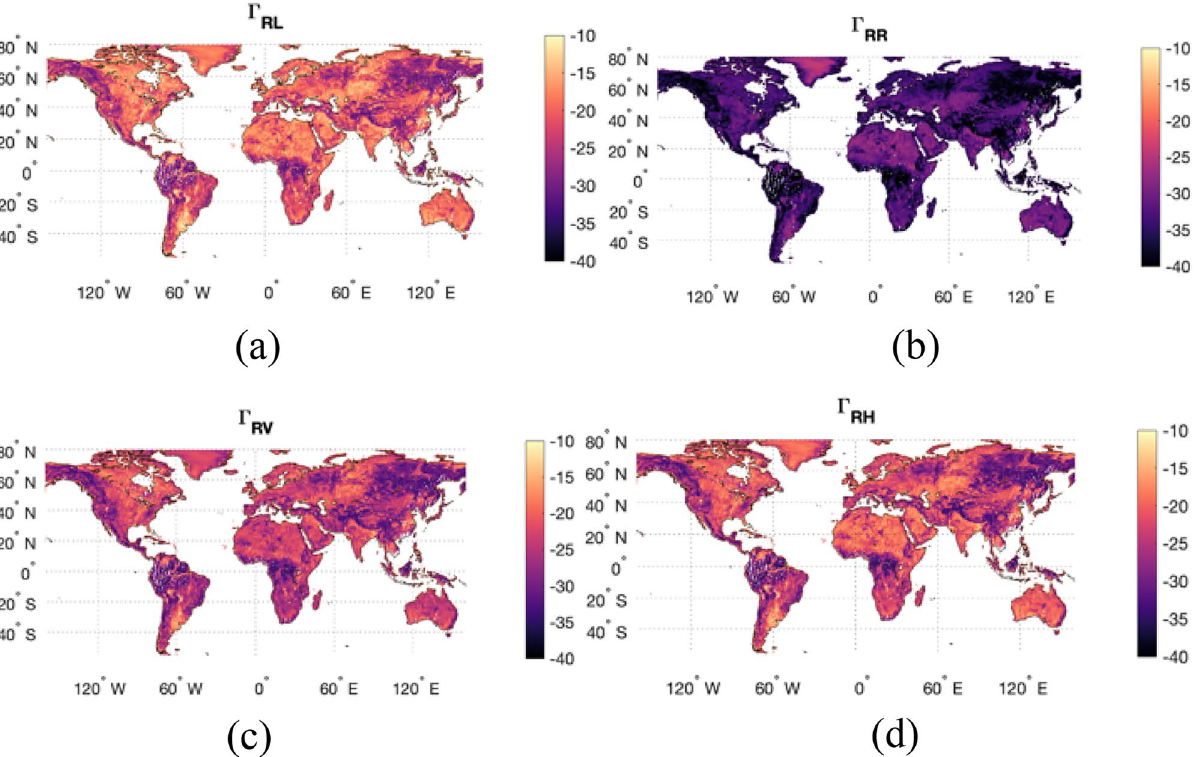
Figure 1. Contrast between bistatic radar signatures of an RHCP transmitted signal scattering from the Earth’s surface and measured with ( a ) an LHCP antenna, ( b ) an RHCP antenna, ( c ) an H polarization antenna and ( d ) a V polarization antenna. Maps were created using have been created using Matlab R2021b (version 9.11.0.1809720, URL: https:// www. mathw orks. com/ produ cts/ new_ produ cts/ relea se202 1b.